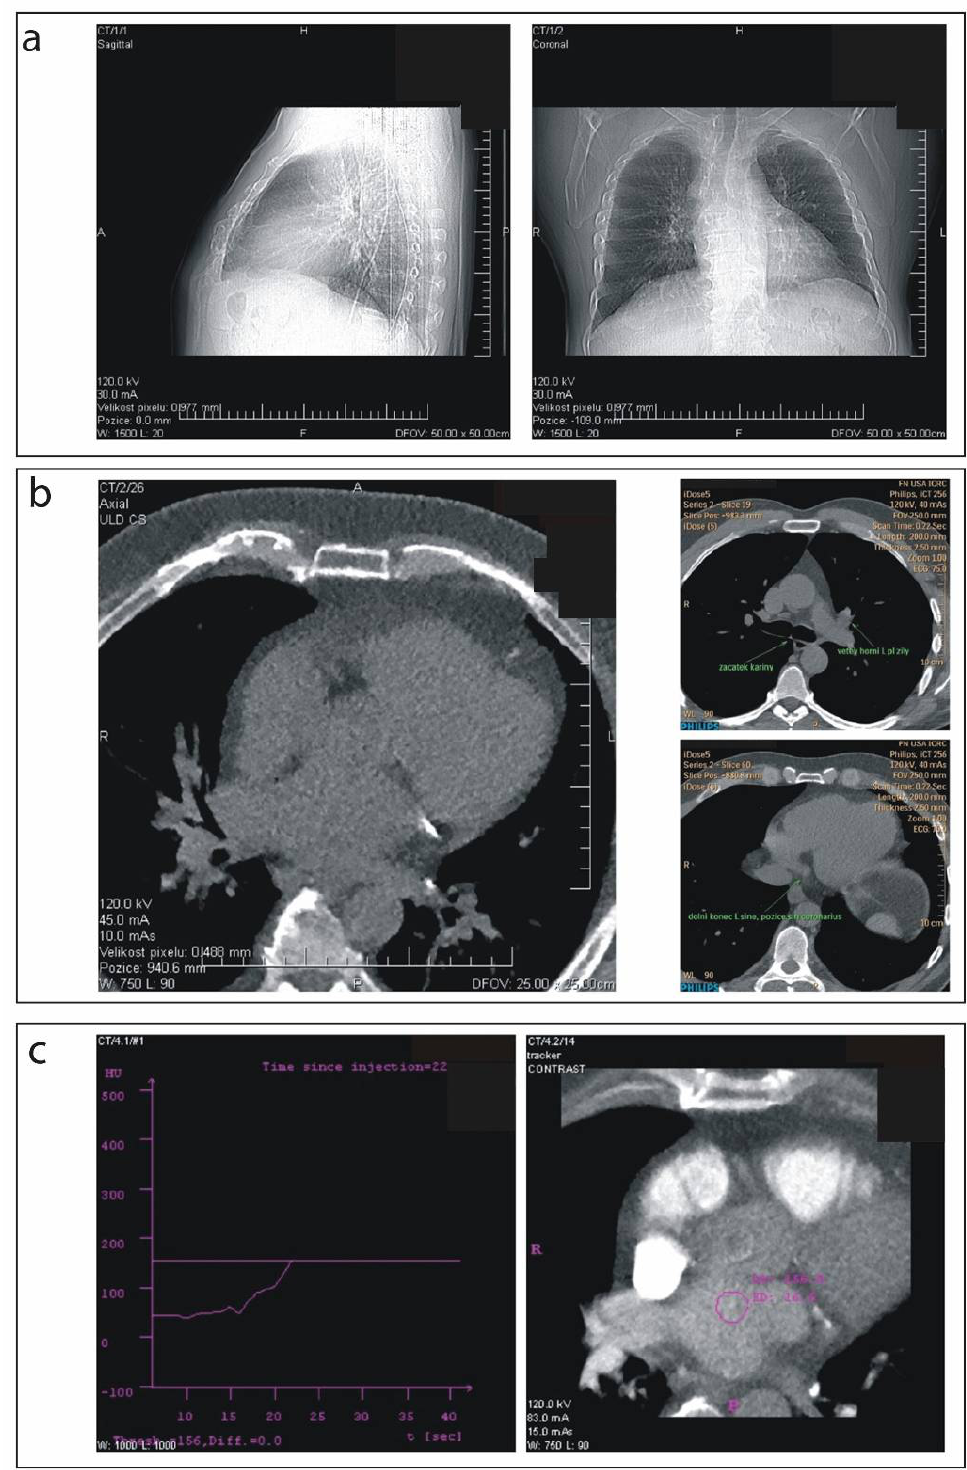
Figure 2. ( a ) Dual surview (scout in the two cross-sections); ( b ) ultra-low-dose calcium scoring; ( c ) setting of contrast agent tracker.